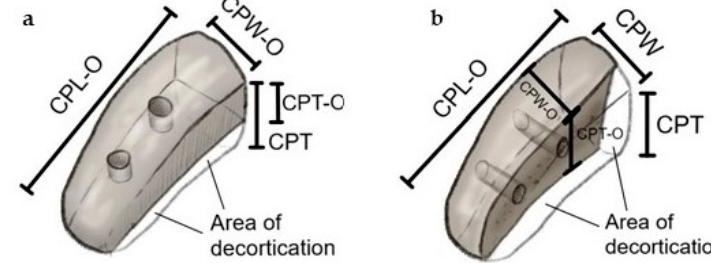
Figure 2. Schematic illustration of a right coracoid process for Classic Latarjet preparation ( a ) and a right coracoid process for Congruent arc Latarjet preparation ( b ). The uncolored area shows the area of decortication at the under-surface in Classic Latarjet grafts ( a ) and at the medial side of Congruent arc Latarjet grafts ( b ). All measurements prior to osteotomy were taken at intact scapulae (native thickness (CPT) and maximum width (CPW) in Figure 2a,b) .